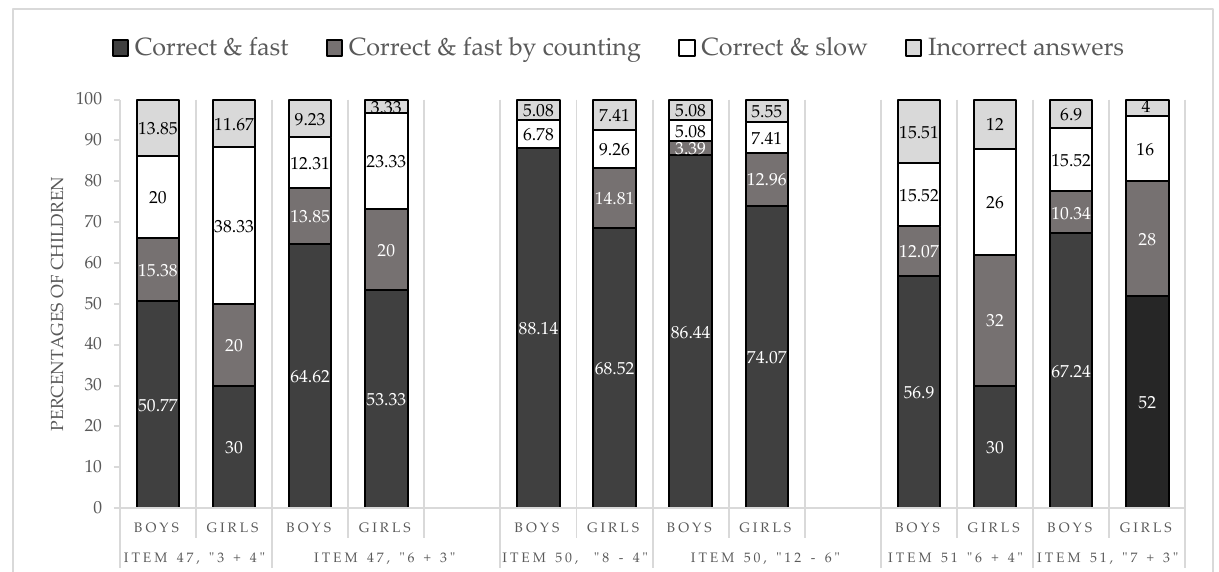
Figure 1. Strategies employed to solve a selection of number-facts problems as a function of gender (items numbering correspond to the TEMA-3 Spanish version [56]). Note. Definition of categories: Correct and fast: correct and fast responses assumed to be obtained by retrieval. They were coded as valid according to the test correction rules. Correct and fast by counting: correct speedy responses obtained by self-reported, explicit or observed counting. They were coded as incorrect according to the test correction rules. Correct and slow: the execution time exceeded the time limit allowed and were coded as incorrect according to the test correction rules. They included correct answers calculated by derived facts, commutative principle or counting. Incorrect answers: erroneous responses, regardless the type of strategy employed. They were coded as incorrect according to the test correction